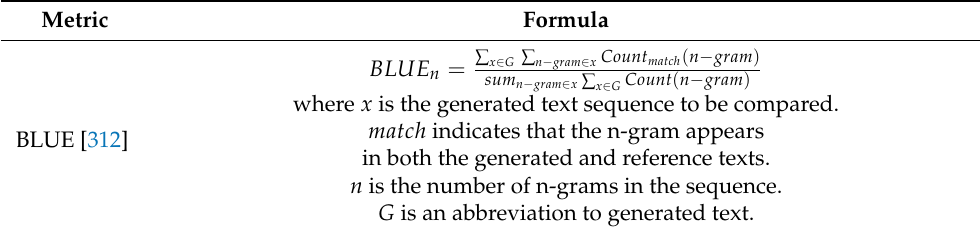
Table 6. List of mathematical formulations for the automatic metrics calculation for the task of TG